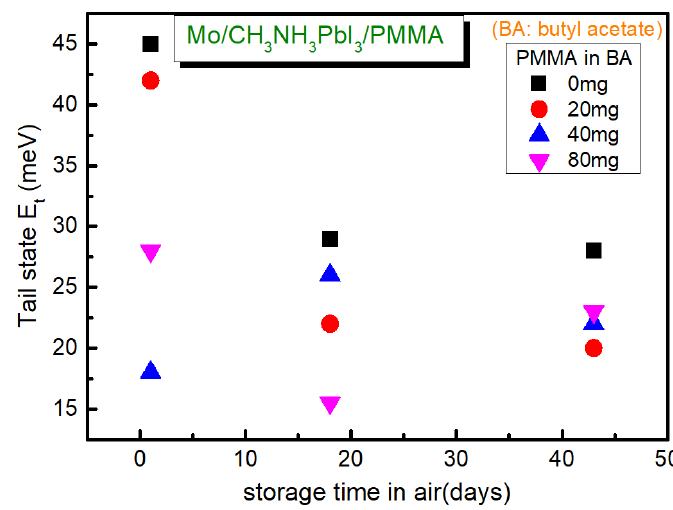
Figure 8 . Tail states of Mo/ CH 3 NH 3 PbI 3 /PMMA with storage time in air for 0 (circle closed black rectangle), 20 (closed red circle), 40 (closed blue triangle), and 80 mg/mL of PMMA (closed pink triangle).